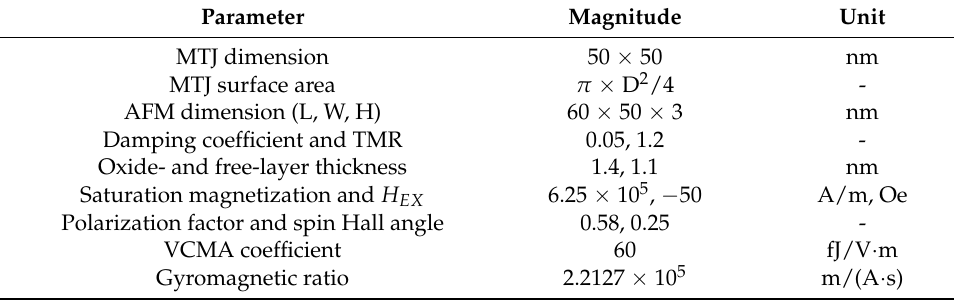
Table 1. MTJ parameters set during electrical simulation.